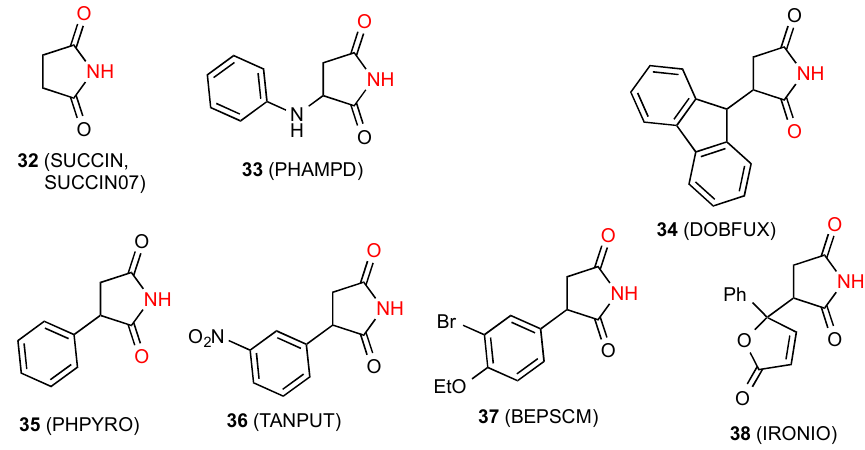
Figure 13. Succinimide and monosubstituted succinimides exhibiting patterns A and B.